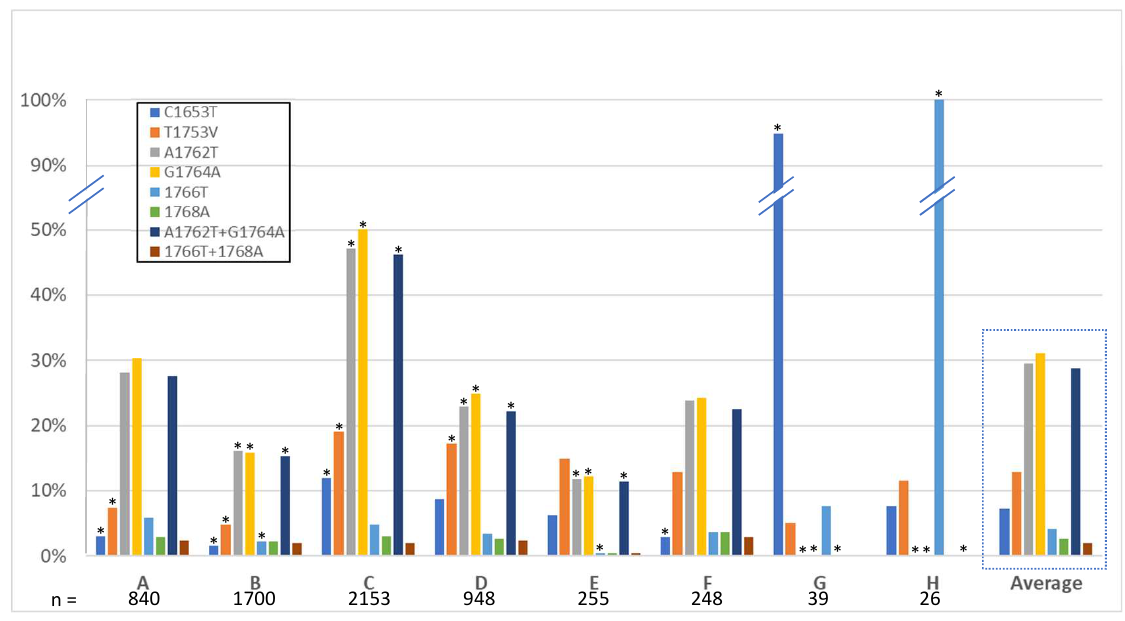
Figure 3. High-risk HCC mutations by genotype. The average of each mutation across all genotypes is outlined by a dashed box. Asterixis refer to significance based on average value.